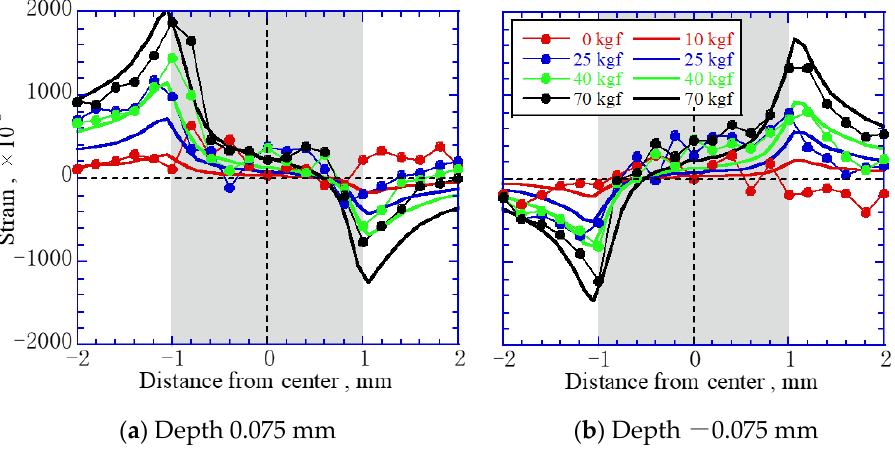
Figure 9. Strain distribution near the interface by FEM (solid line) and measurements (dotted line). FEM analyses were calculated assuming the Young ’ s modulus of the weld was 1.1 times that of the base metal.